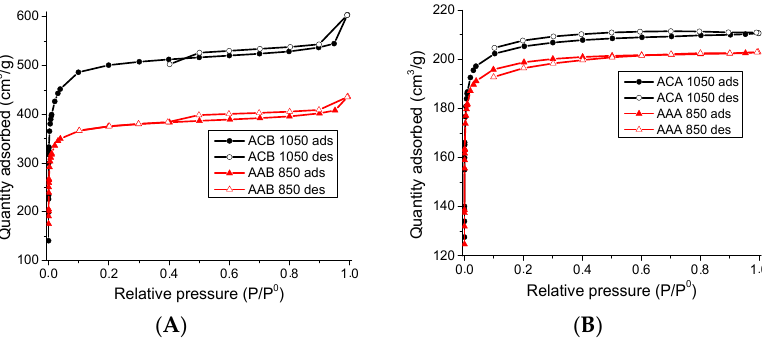
Figure 1. Physisorption isotherms of N 2 at −196 °C of the carbon aerogels obtained in: ( A ) basic medium; and ( B ) acidic medium.